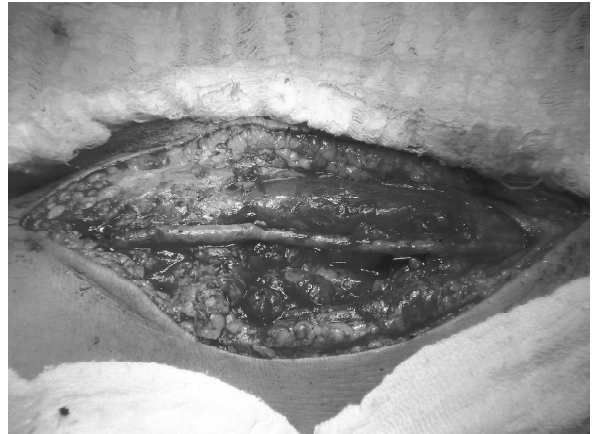
Fig. 3 - Aspecto final após ressecção do aneurisma com interposição de enxerto de safena reversa em localização